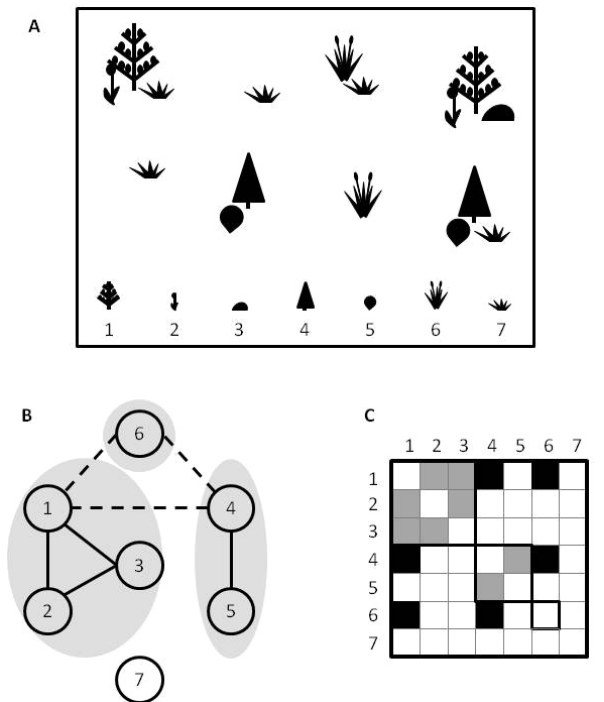
Figure 1. Ecological meaning of partitions in plant–plant spatial as- sociation networks. (A) Spatial association of plant species. Species can associate forming a multispecific vegetation patch (species 1, 2 and 3 always co-occur in space), can segregate separating differ- ent types of vegetation patches (species 1, 4 and 6 never co-occur in space), or can associate randomly (species 7 co-occurs with all species but also appears alone). (B) Plant–plant spatial association networks. Nodes represent species and links represent the spatial association between pairs of species (complete lines are positive spatial associations, and dashed lines are negative spatial associa- tions). Network is divided in partitions (grey circles), so that species within a partition connect with positive links (species 1, 2 and 3) while species from different partitions connect with negative links (species 1, 4 and 6). Nodes that do not connect to others (species 7) are not included in any partition. (C) Matrix for plant–plant spatial association networks. Nodes are rows and columns of the matrix and the intersection between two nodes represents their link (grey squares are positive links, while black squares are negative links).